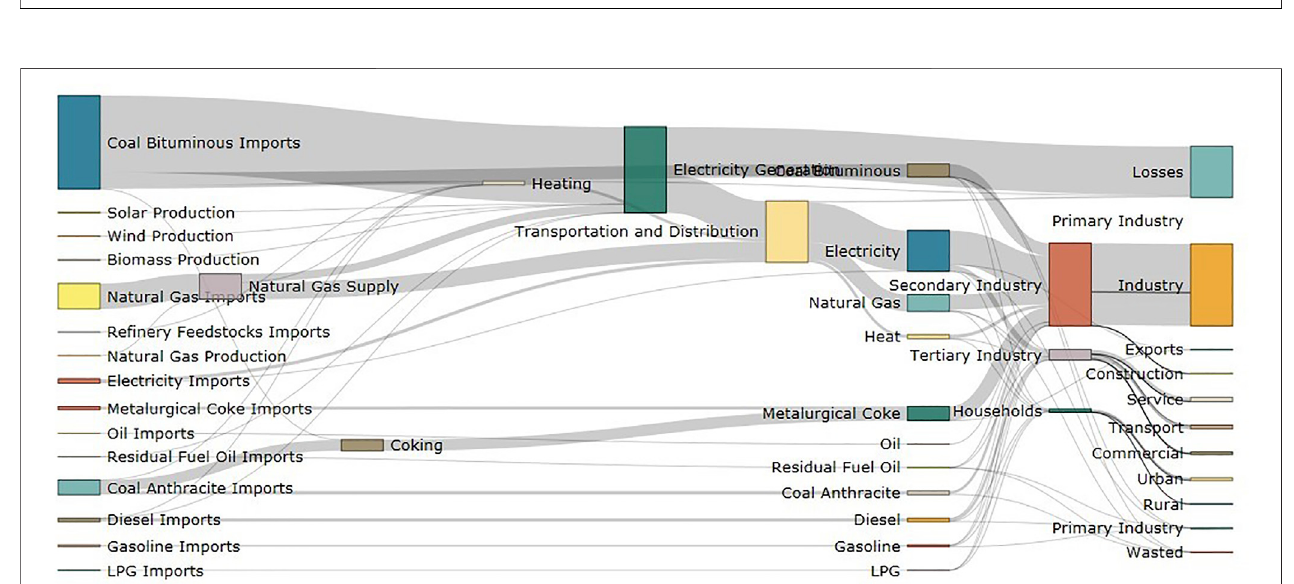
FIGURE 8 | Energy fl ows in 2030 under the BAU scenario.